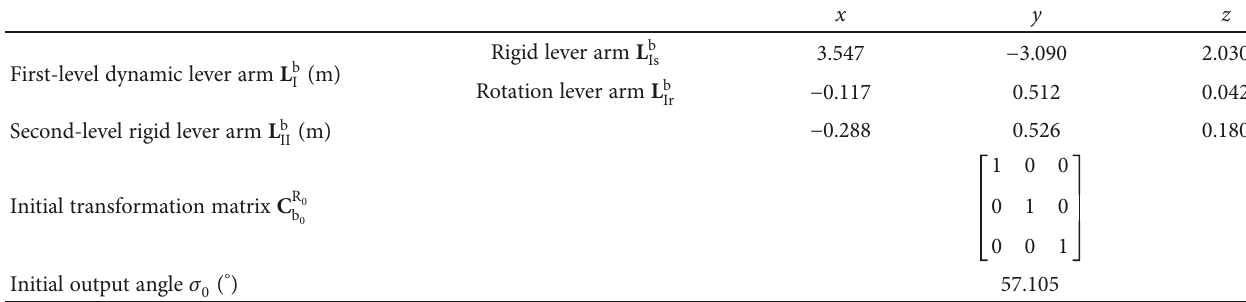
Table 1: Calibration result of the experiment system in Figure 4.